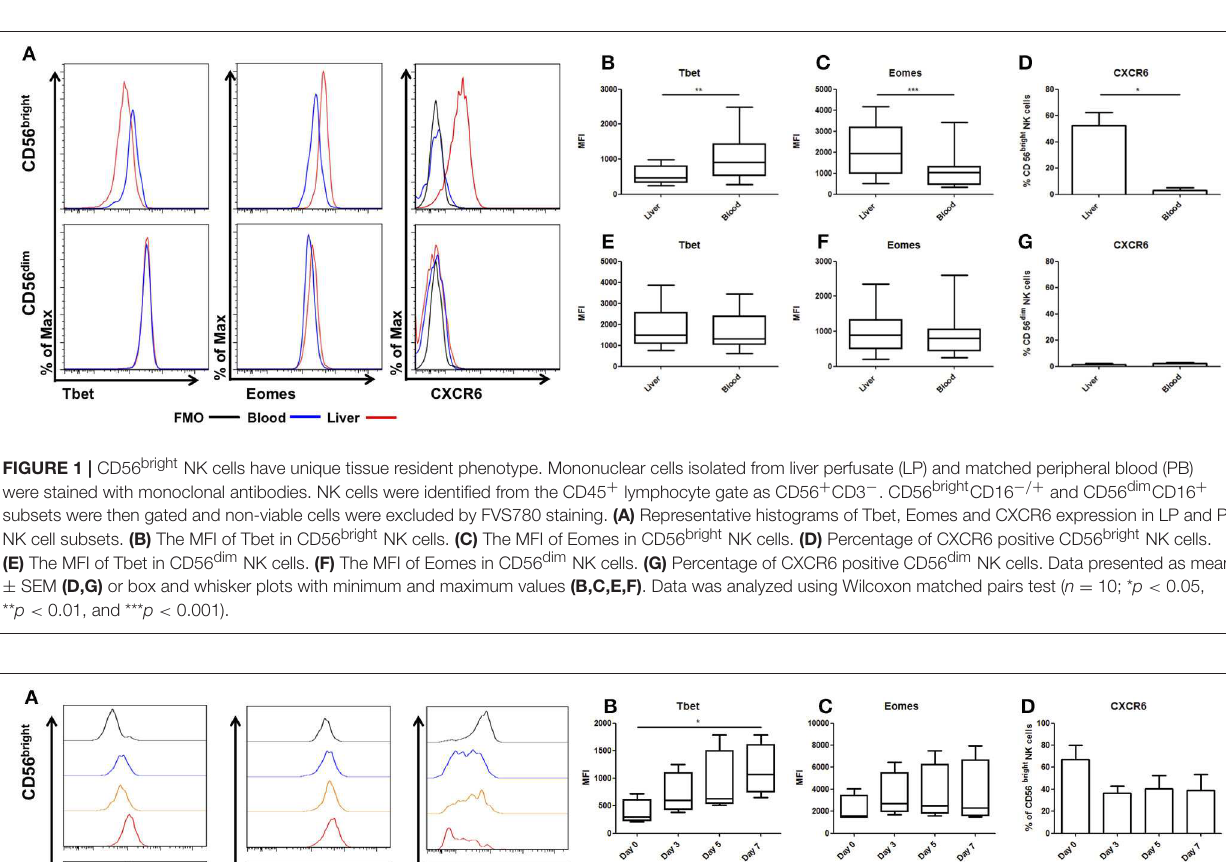
(untreated 6.6 ± 2.4%, 5% LCM 3.6 ± 2.1%, 10% LCM 4.1 ± 2.6, p = 0.72, Figure 3G ).